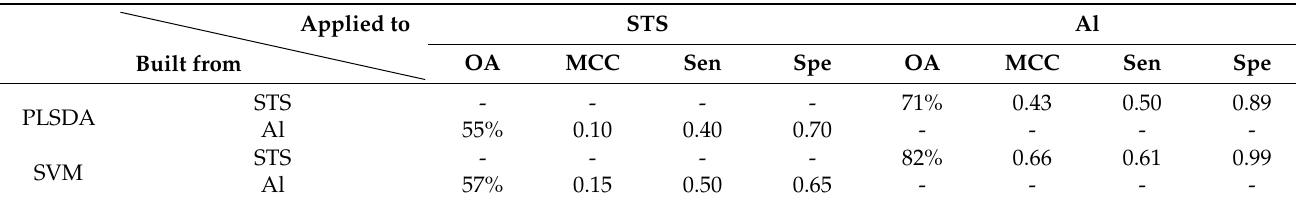
Figure 5. Classification maps obtained from the SVM model using 3500–2600 cm − 1 for all sam- ples deposited on Aluminium substrate. The training set consists of the first four images of each concentration, and the test set comprises the remaining four images of each set. Table 6. Modelling performance obtained from the model built from one substrate and transferred to the other substrate using 3500–2600 cm − 1